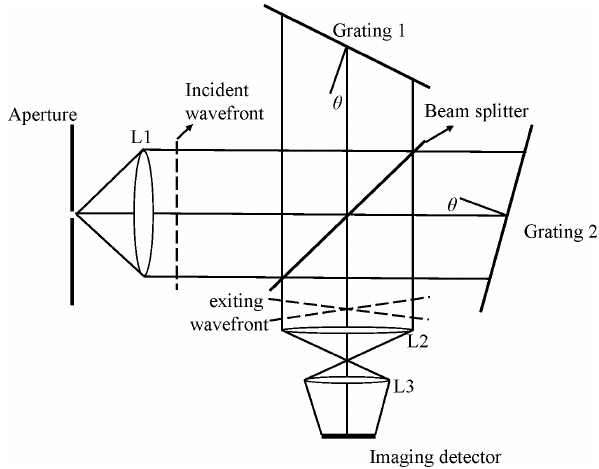
Figure 1. Schematic diagram of spatial heterodyne